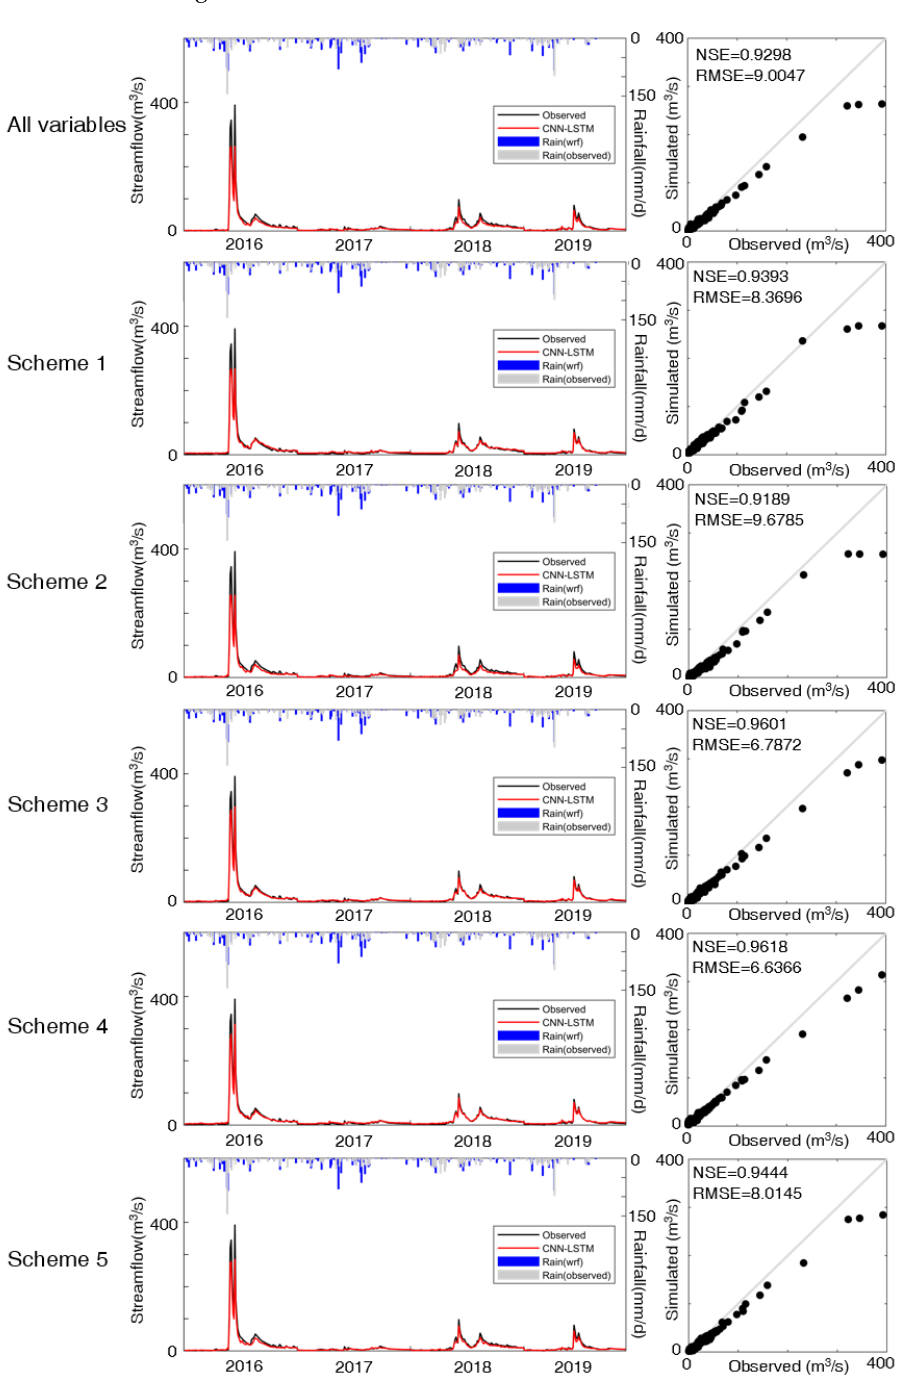
Figure 5. Performance of the CNN-LSTM model in the Fuping catchment during 2016–2019.